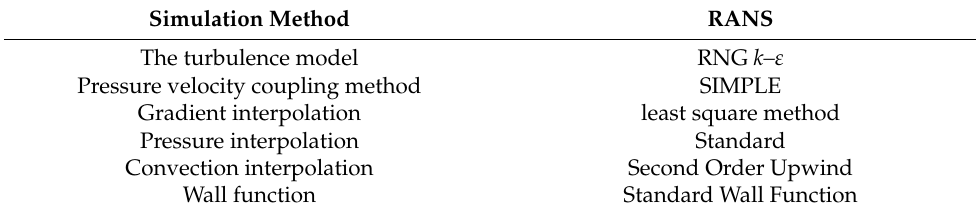
Table 5. Turbulence model, discrete format, and